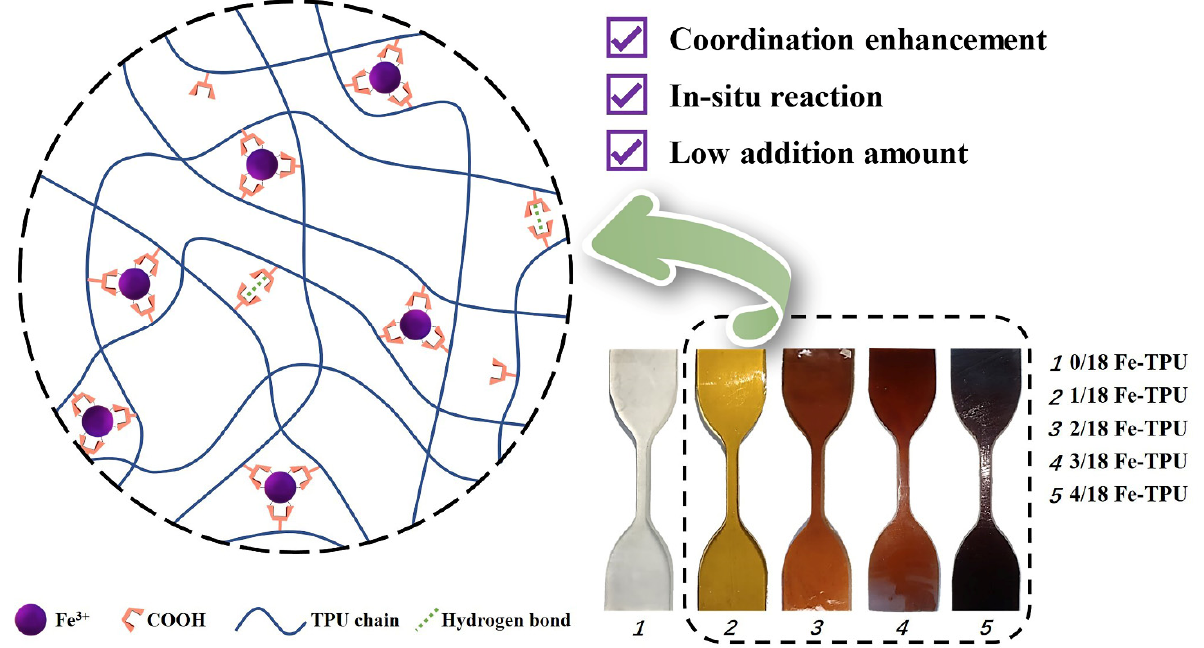
Figure 1. Model of TPU reinforced with FeCl 3 .